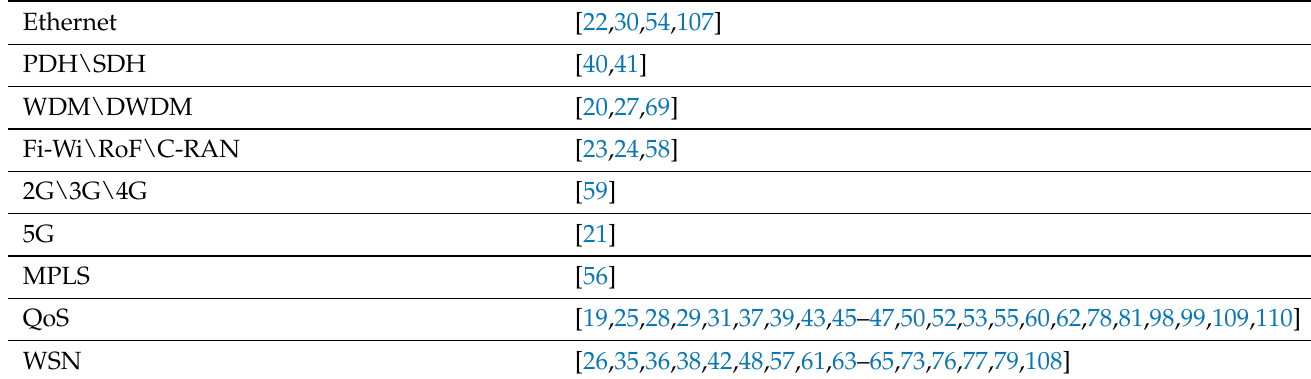
Table 7. Articles that can be classified by means of their